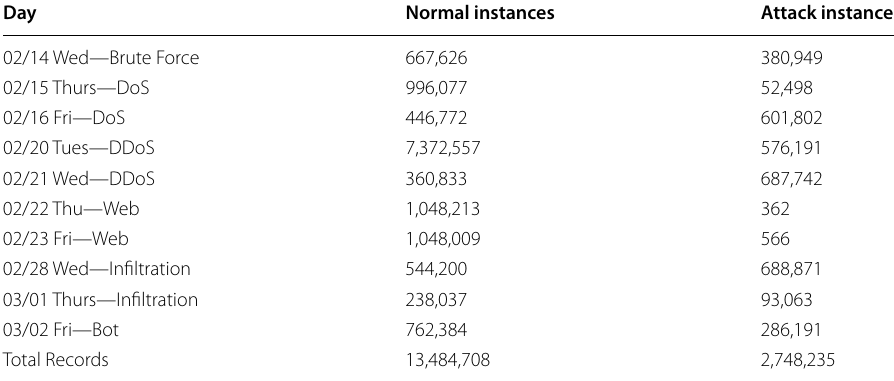
Table 1 Entire CSE-CIC-IDS2018 dataset by files/days (only web attacks and normal traffic are used in our experiments) Day